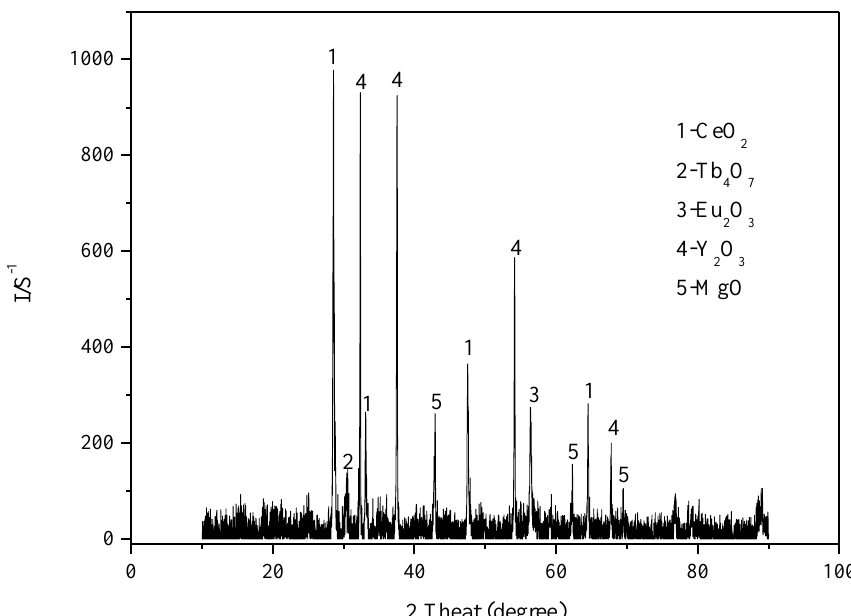
Figure 5. XRD pattern of the water-washing residue of the roasting product under the condition of 0.5% oxygen concentration.